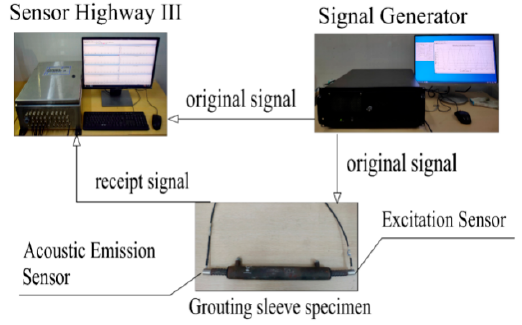
Figure 3. Test device.